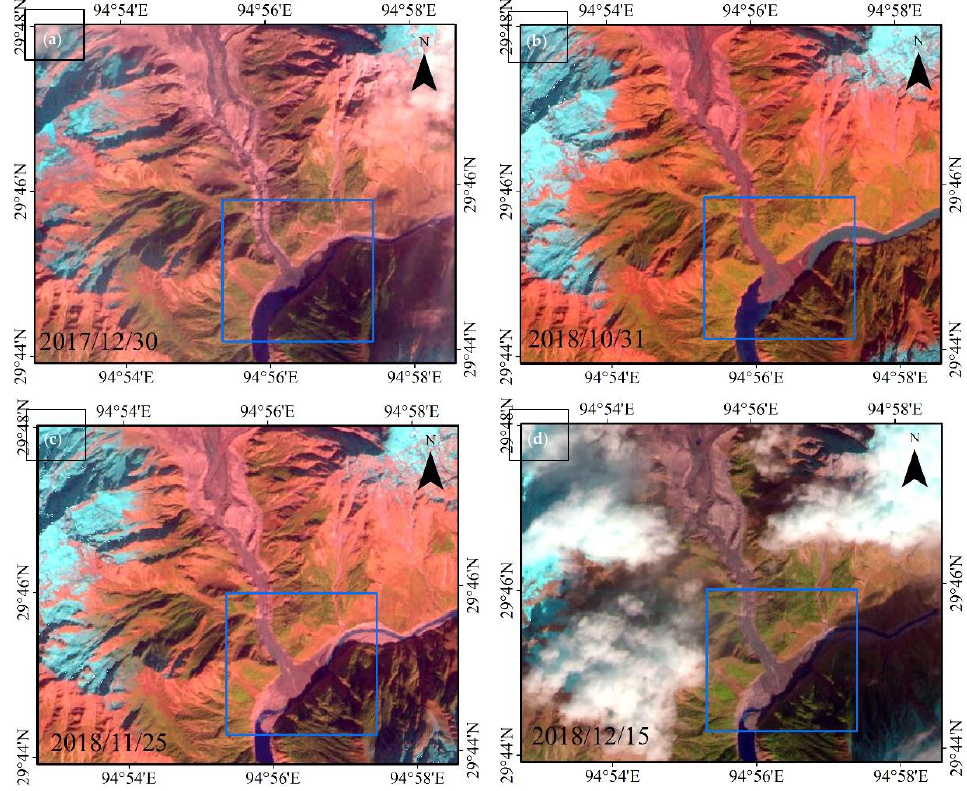
Figure 3. Examples of river-blocking events on images of Sentinel-2 in Yarlung Zangbo River: ( a ) 30 December 2017; ( b ) 31 October 2018; ( c ) 25 November 2018; ( d ) 15 December 2018; the blue box is the region blocking the river.